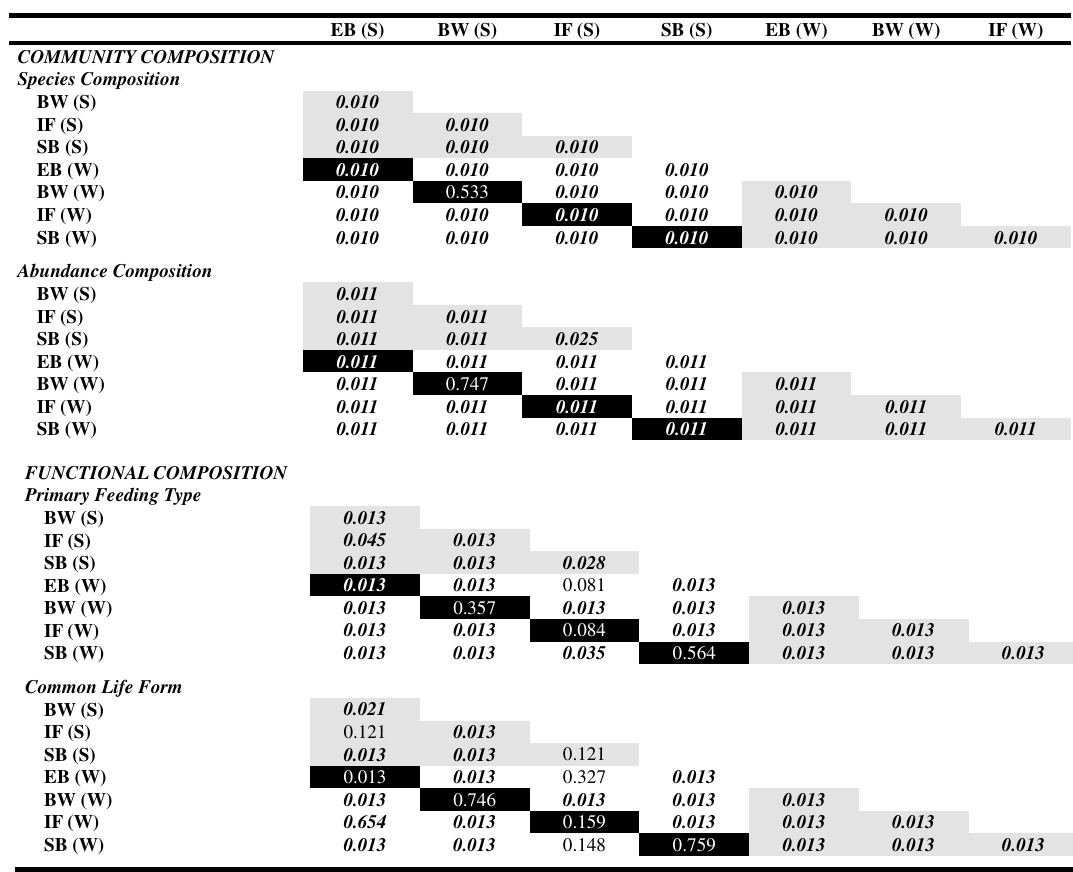
Table 3. P- values obtained from post-hoc tests (pairwise PERMANOVAs) testing for similarities in community and functional composition across habitats and sampling times (S: summer; W: winter). Significant P -values ( P < 0.05) are shown in bold italic typeface. Grey cells show comparisons among habitats within sampling times. Black cells show comparisons between sampling times for each habitat. Habitat abbreviations are as shown in Fig.